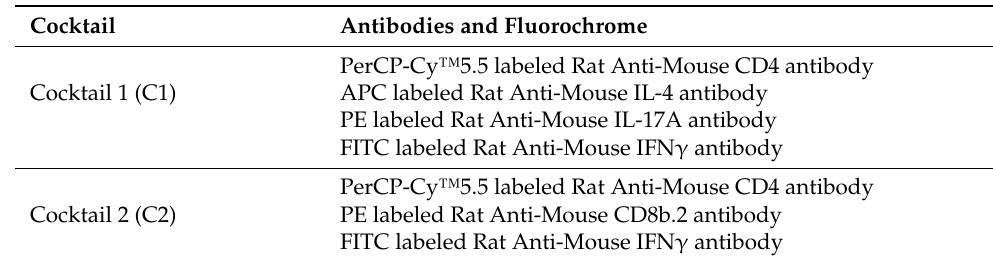
Table 2. Flow cytometry fluorochrome cocktails. All antibodies were rat anti-mouse with a directly conjugated fluorochrome (BD